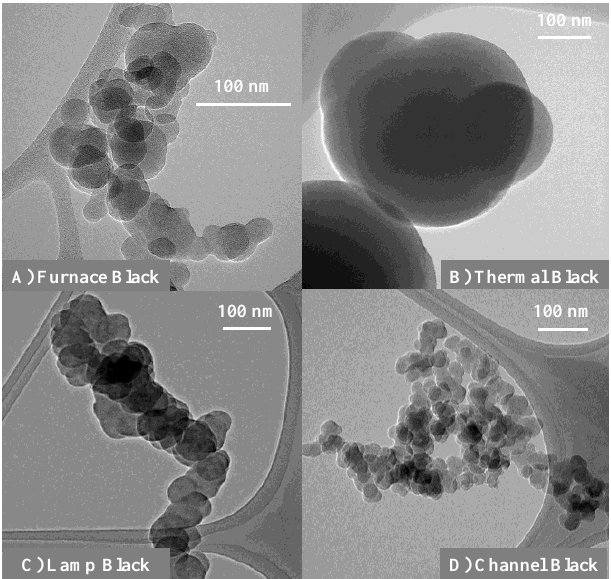
Figure 1. TEM images showing aggregates of ( A ) furnace, ( B ) thermal, ( C ) lamp, and ( D ) channel blacks.